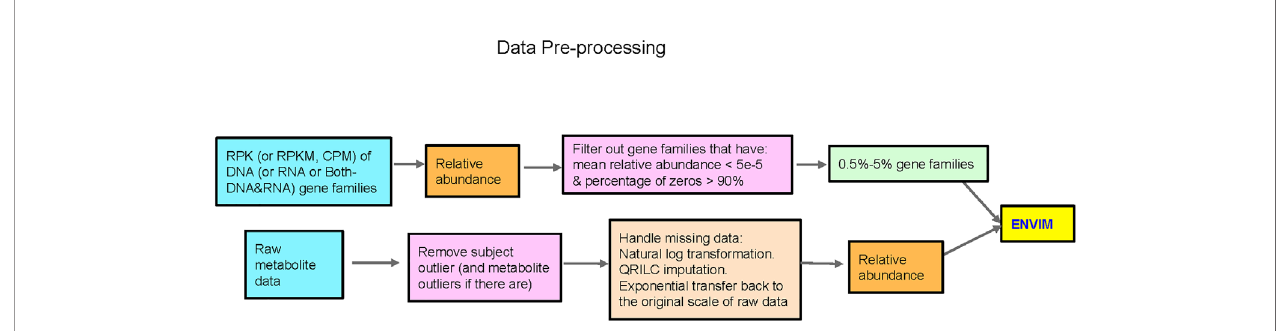
FIGURE 1 | Flowchart of data preprocessing in microbiome and metabolome. QRILC was not used for the Mallick data, but was used for the ZOE 2.0 and Llloyd- Price data. Metabolites that have percentage of NA > 90% will also be removed before handling